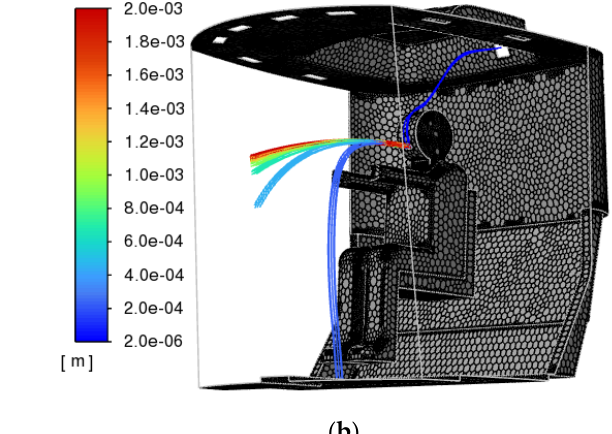
( c ) Figure 14. Trajectories and diameters of pathogen particles for deflectors versus time, the colors on the scale of values correspond to the size of particle diameters: ( a ) time 0.4 s; ( b ) time 1.2 s; ( c ) time 127 s.